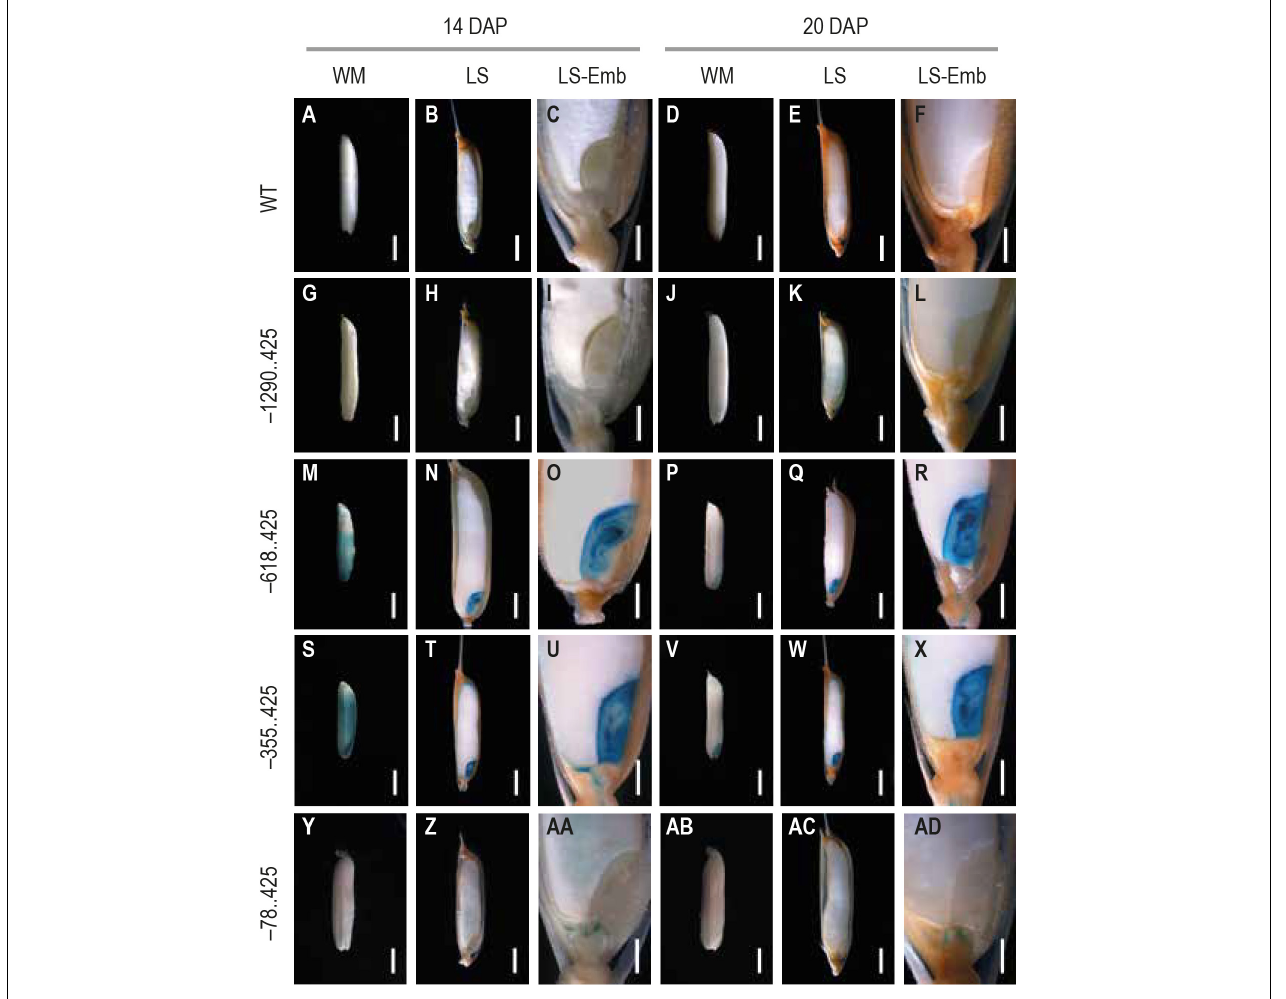
FIGURE 4 | Analysis of GUS expression in mature seed stages 14 and 20 DAP from WT and transgenic plants. The panels show whole mounts (WM), hand-cut longitudinal section (LS), and a magnification of the LS showcasing the embryo (LS-Emb) of mature 14 and 20 DAP seeds from (A–F) WT, (G–H) − 1290..425, (M–R) − 618..425, (S–X) − 355..425, and (Y–AD) − 78..425 rice transgenics. Samples were photographed using a Leica Mz12.5 Stereozoom microscope. The scale bar in 14 and 20 DAP WM, and LS samples represents 2 mm and in LS-Emb samples is 0.5 mm.